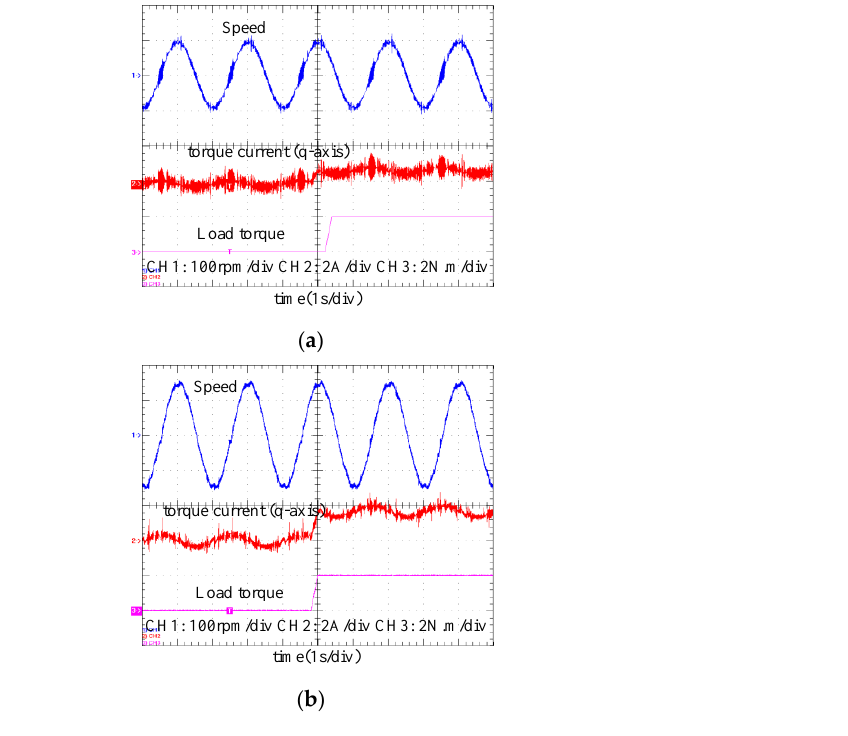
Figure 16. Speed and torque current ( q -axis) experimental results. ( a ) NMPSC with the proposed method; ( b ) Conventional NMPSC.